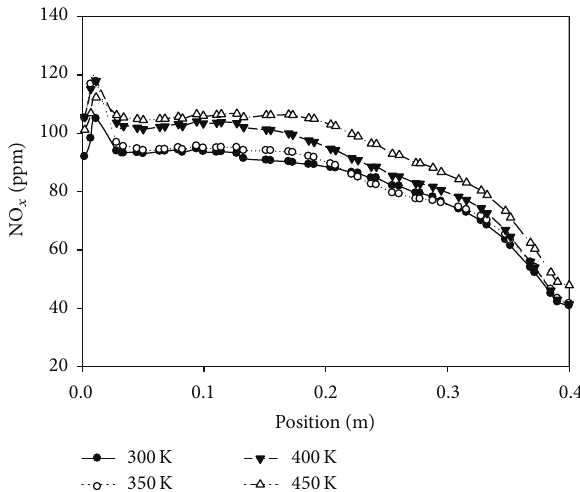
Figure 11: The effect of preheating fuel on the central temperature profile.